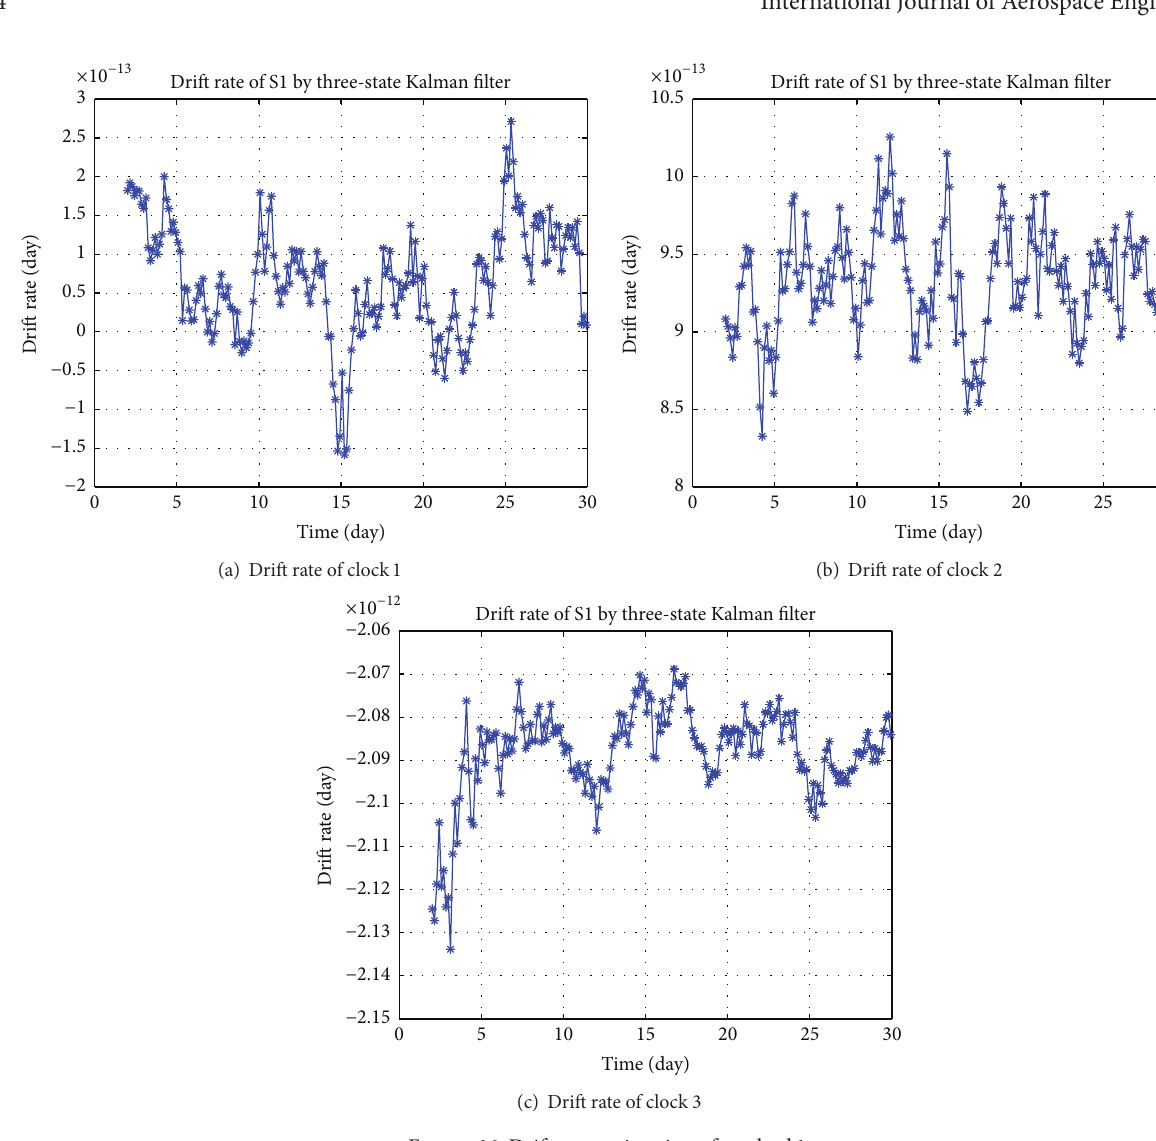
Figure 16: Drift-rate estimation of method